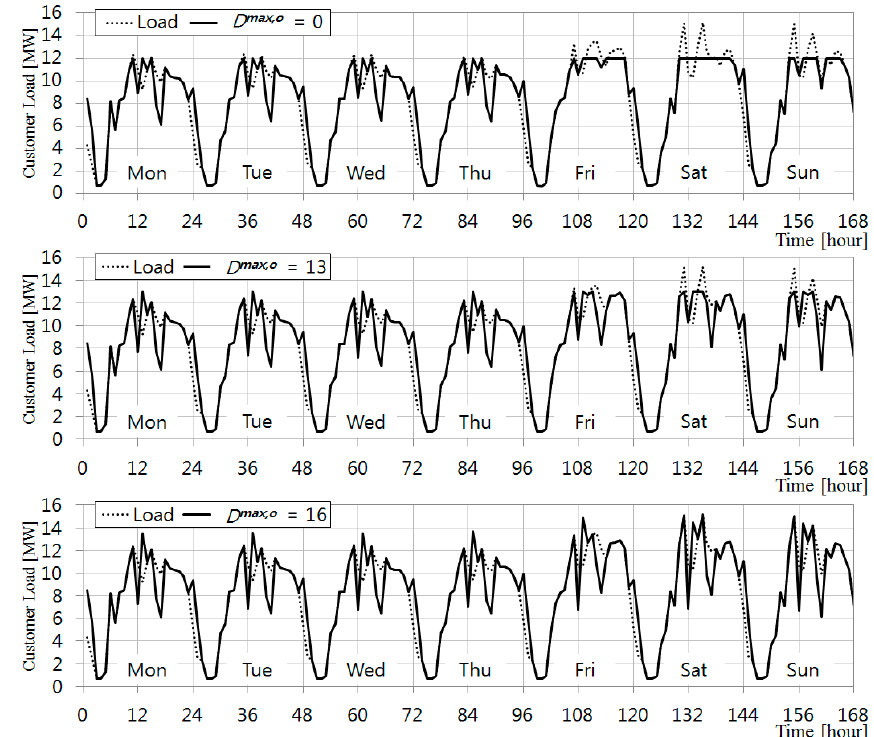
Figure 7. Weekly operation results for the customer electric bill minimization.